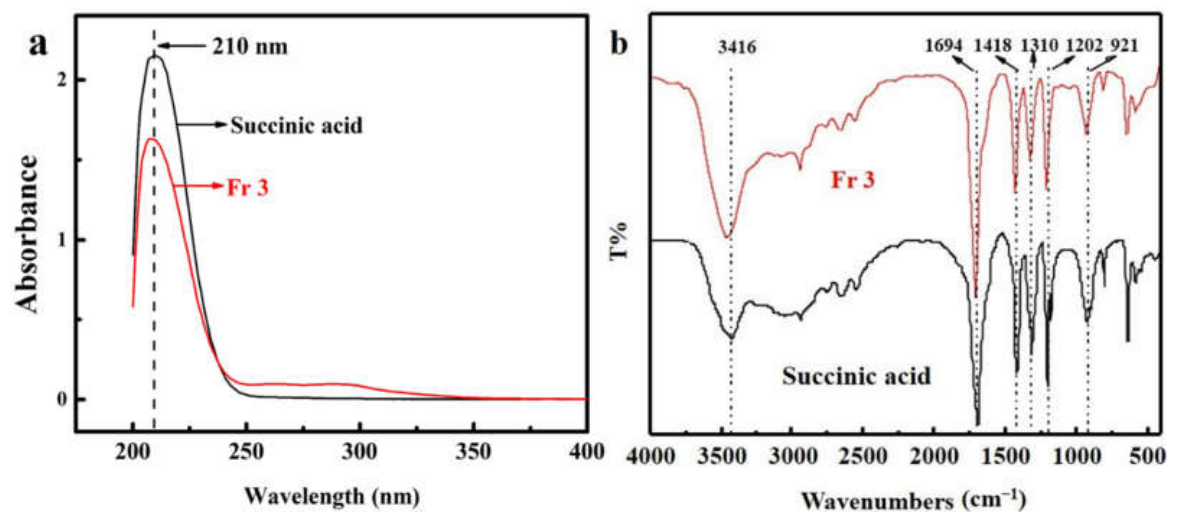
Figure 3. UV-vis absorbance spectra ( a ) and FT-IR spectra ( b ) of Fr 3 and succinic acid.